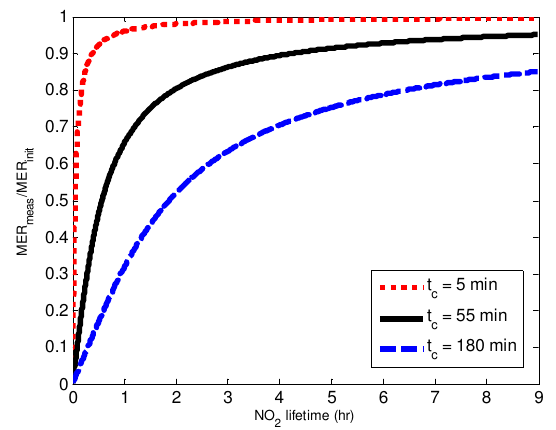
Fig. 2. The NO 2 mass emission rate (MER) measured in this anal- ysis (as a fraction of the initial MER from the fire) vs. NO x lifetime in the plume (Eq. 10) for three sample clear times in our analysis: the shortest (5min), average (55min) and longest